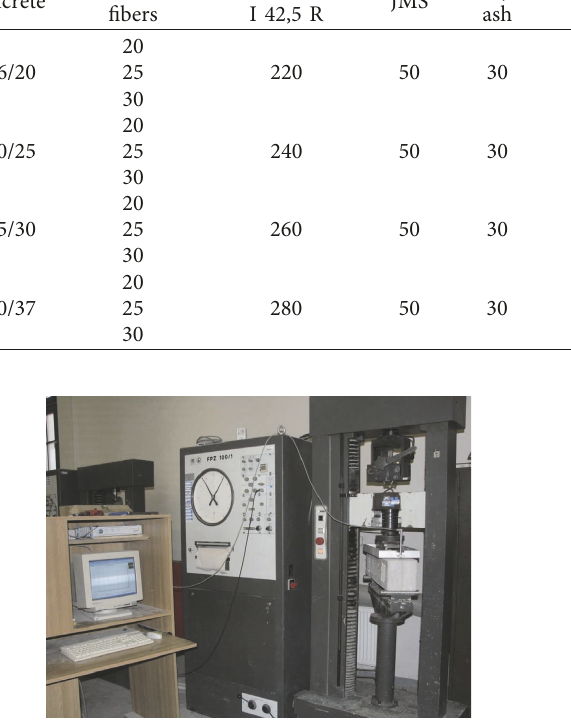
Figure 1: Process of the bending test of the SFRC